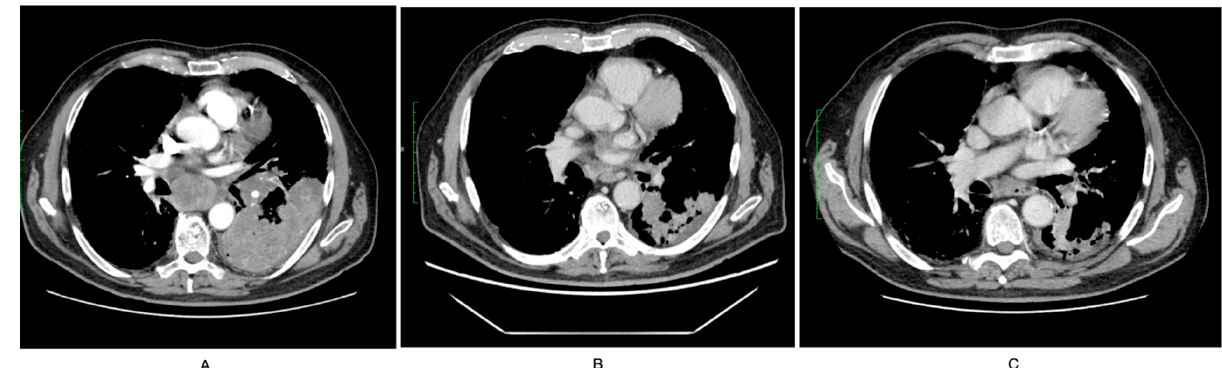
Figure 2. Efficacy of chemotherapy: before treatment ( A ), after 2 cycles ( B ) and after 4 cycles ( C ).